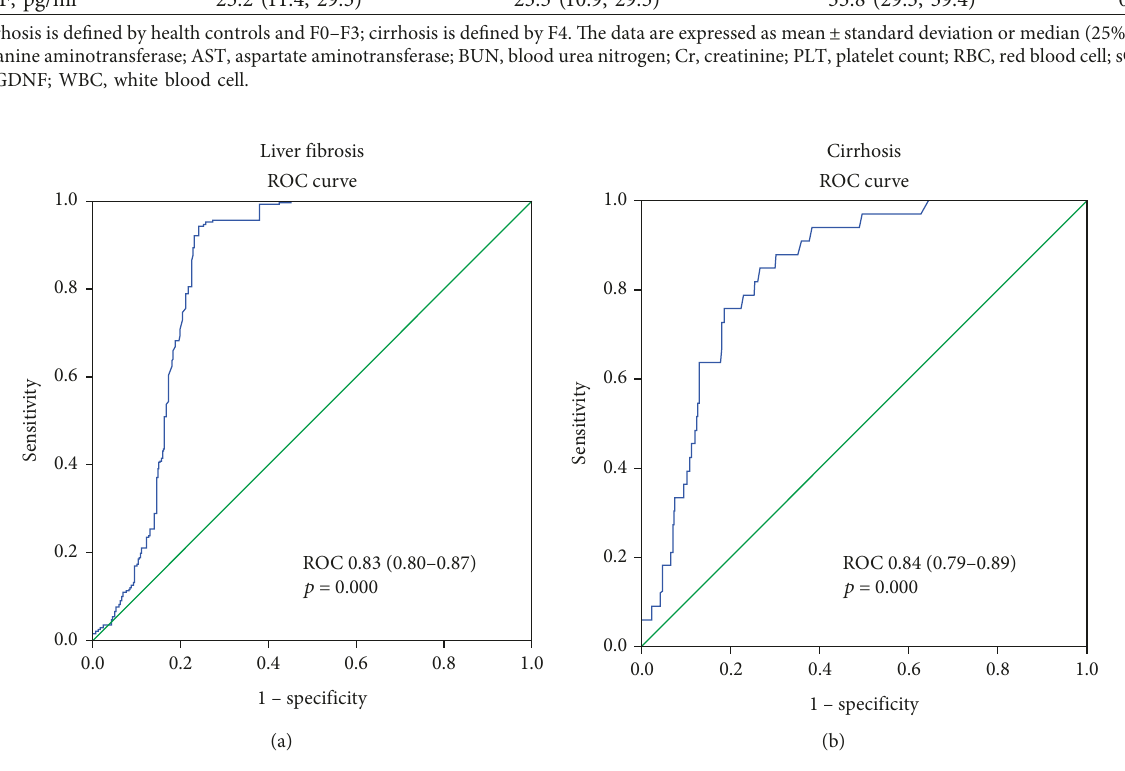
Figure 1: Receiver operating characteristics (ROC) analysis showing the predictive value of sGDNF for liver fibrosis in patients with CHB. Receiver operating characteristic curve for sGDNF predicting liver fibrosis (a) and cirrhosis (b). The estimates indicate the area under the ROC